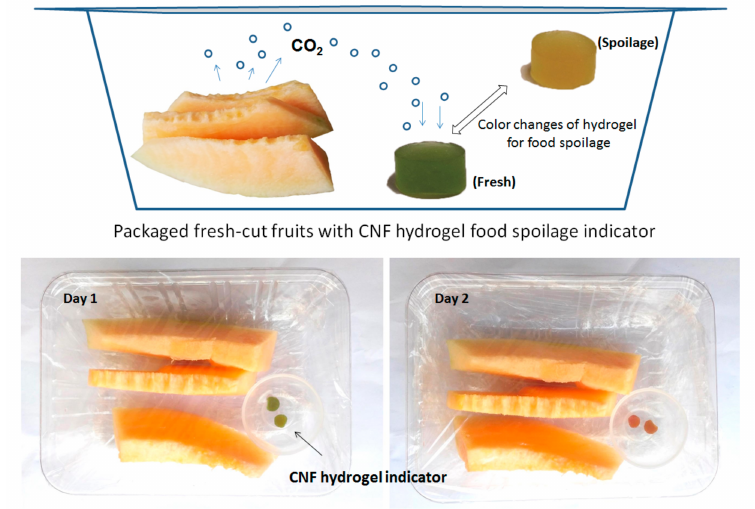
Figure 8. Scheme of colored CNFs hydrogels for intelligent food packaging